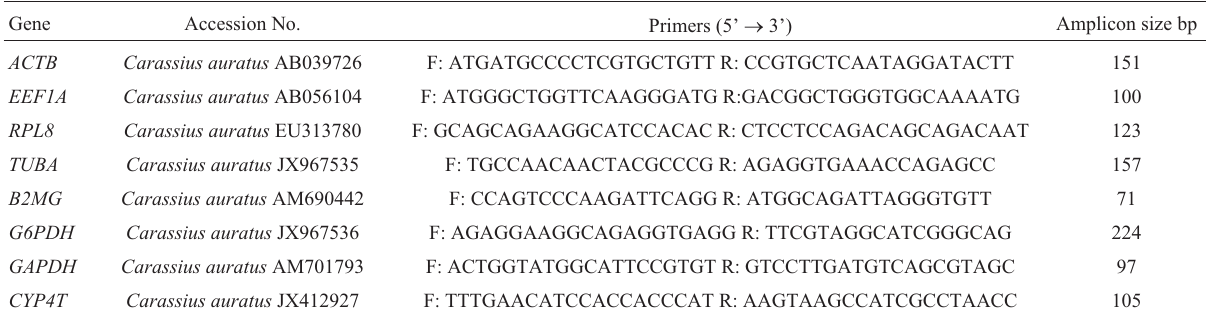
Table 2 - Primers for RT-qPCR